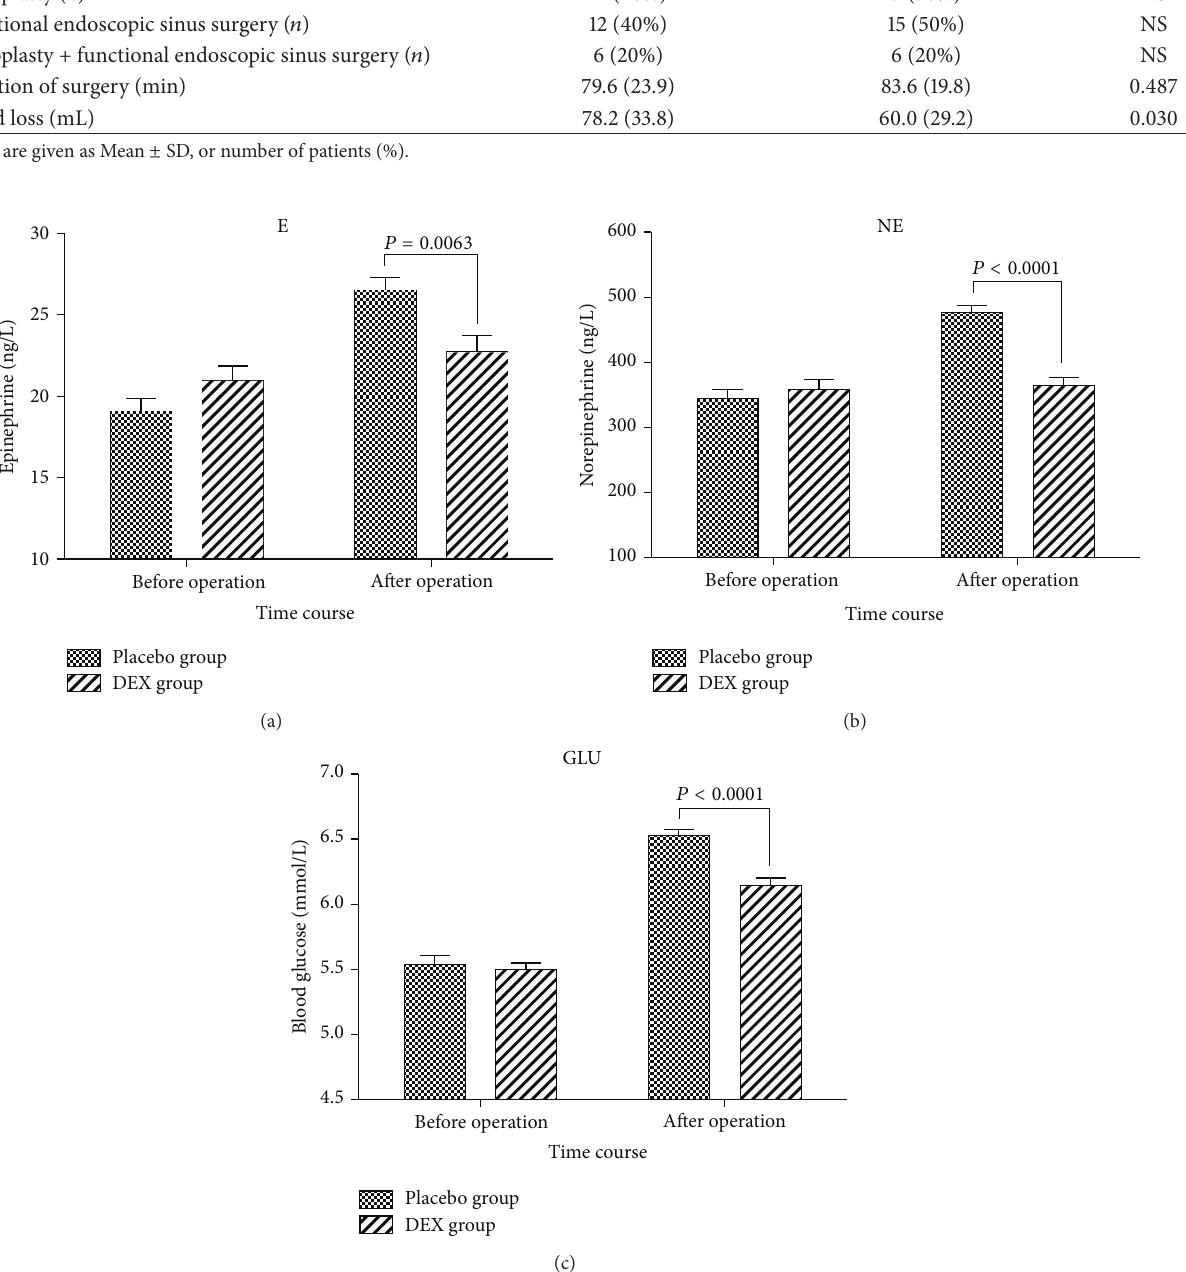
Figure 2: Plasma epinephrine, norepinephrine, and blood glucose level of patients receiving intranasal DEX and placebo before operation and after operation. Values are given as mean ± SEM. Between-group comparison of epinephrine, norepinephrine, and blood glucose after operation. DEX group was lower than that of Placebo group ( 𝑃 = 0.0063 , 𝑃 < 0.0001 , and 𝑃 < 0.0001 ,